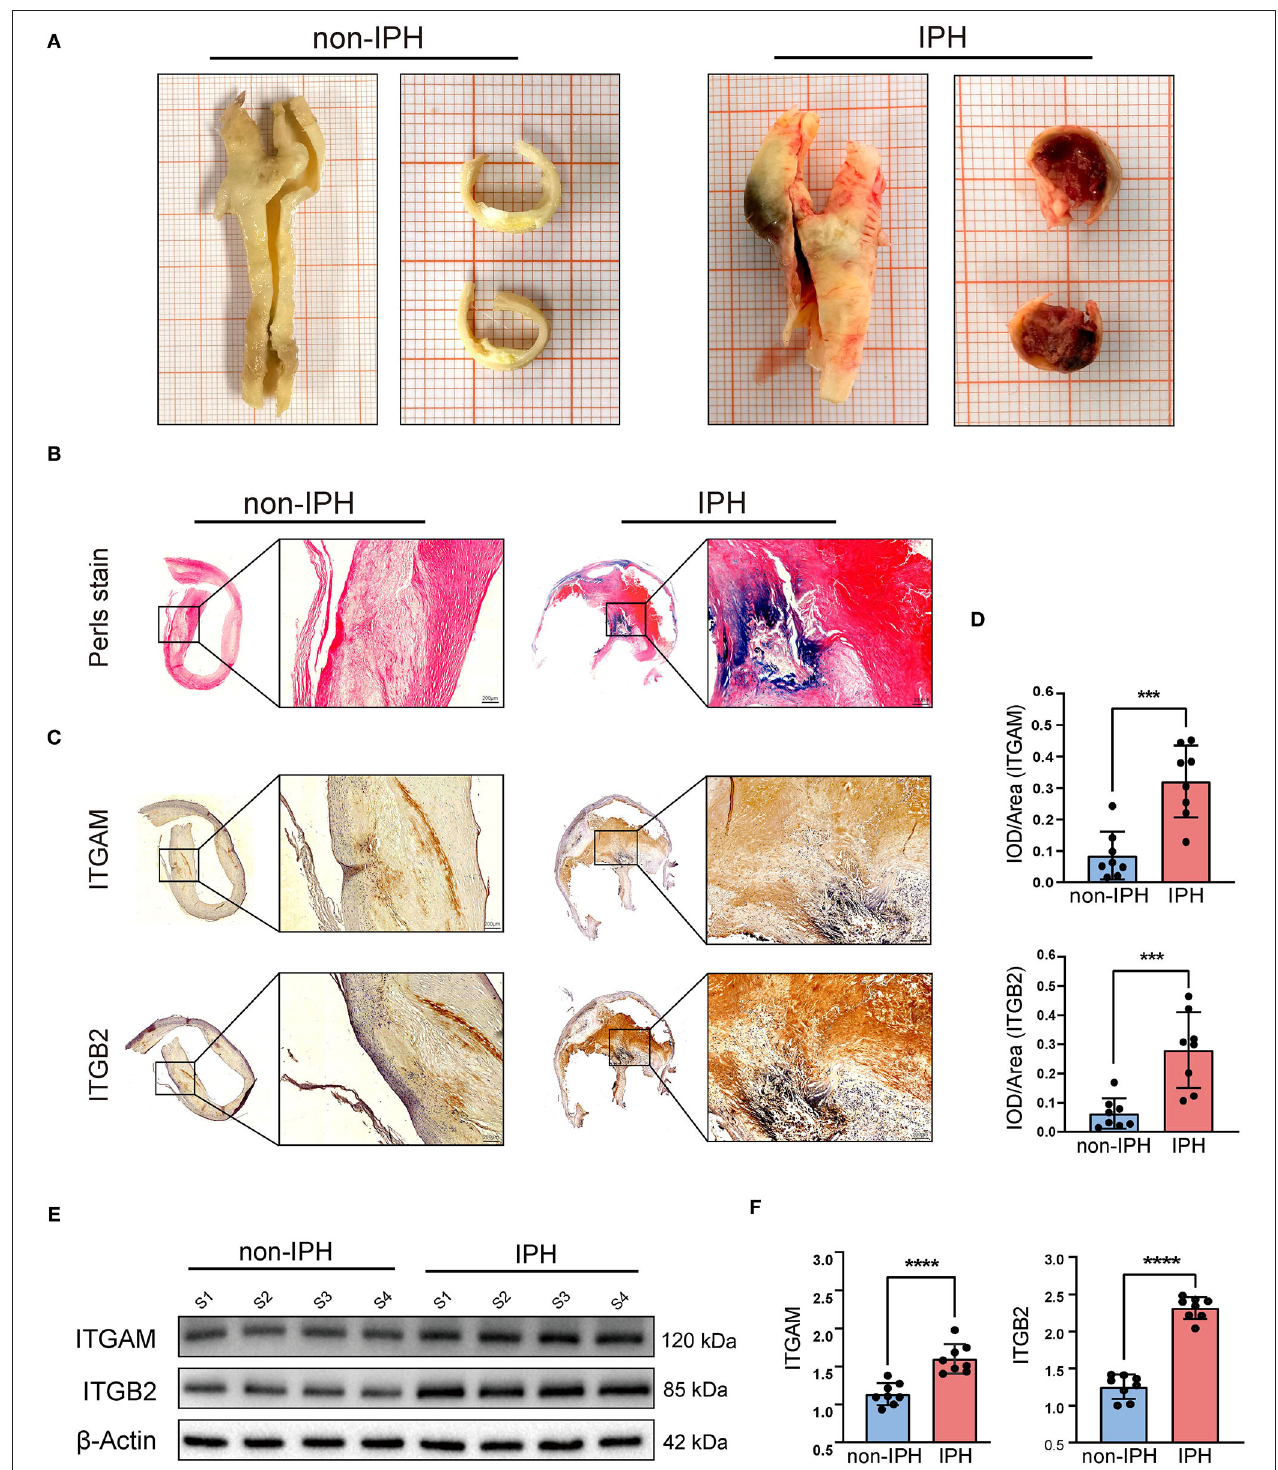
FIGURE 8 | Validation of the hub genes ( ITGAM and ITGB2 ). (A) Fresh human carotid atherosclerotic plaque specimens were collected from carotid endarterectomy. Plaque features can be preliminarily observed in gross specimens and cross sections. From left to right, atherosclerotic plaques without IPH and with IPH are shown. (B) Perls staining was used to further identify the plaques. The IPH plaque section showed obvious blue staining and infiltration of erythrocytes by light microscopy. (C) Typical micrographs of ITGAM and ITGB2 immunohistochemical staining, macroscopic, and microscopic views of the cross sections from left to right. (D)